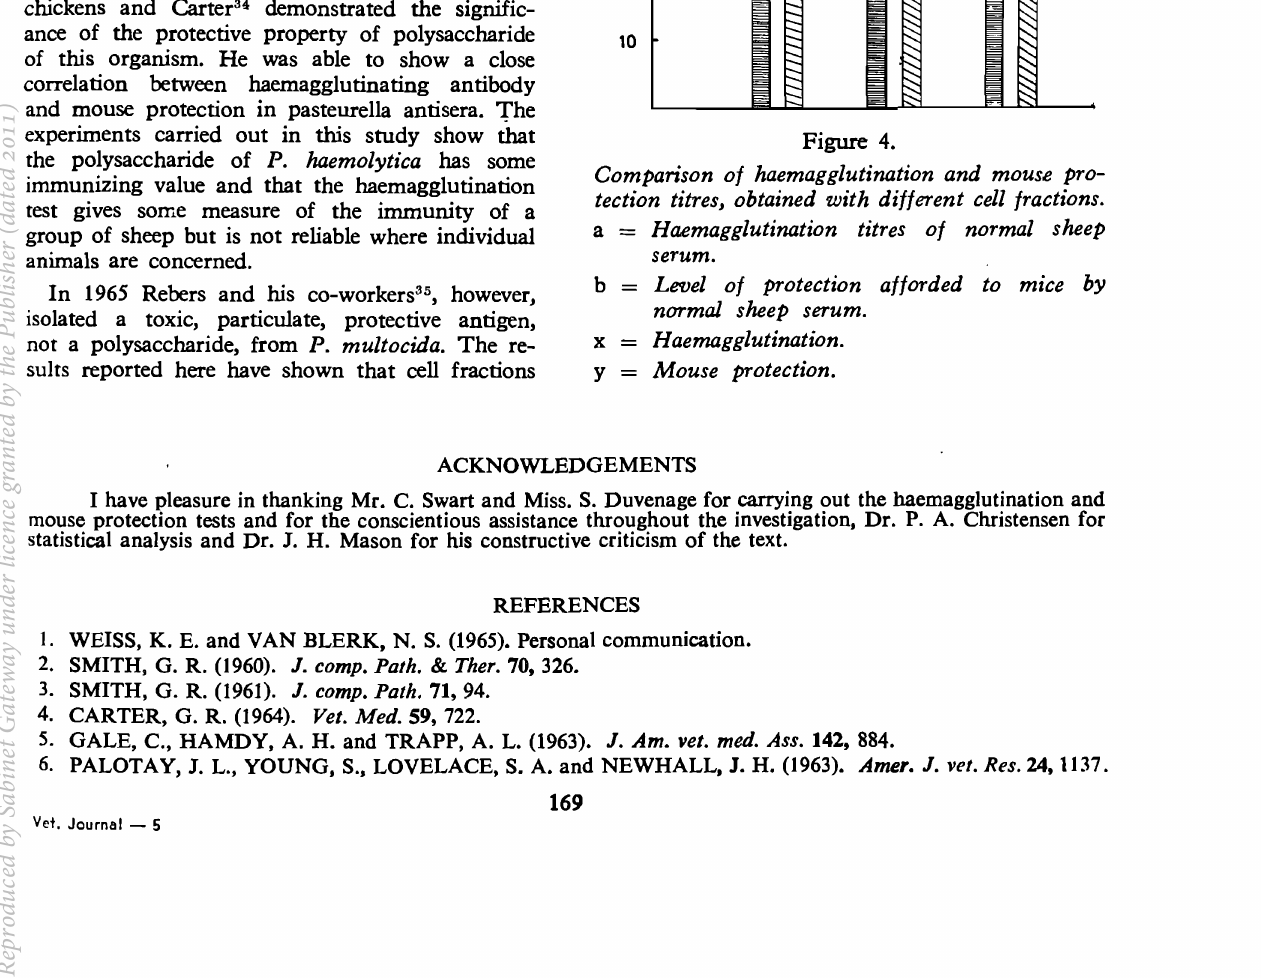
Haemagglutination titres obtained with different cell fractions.